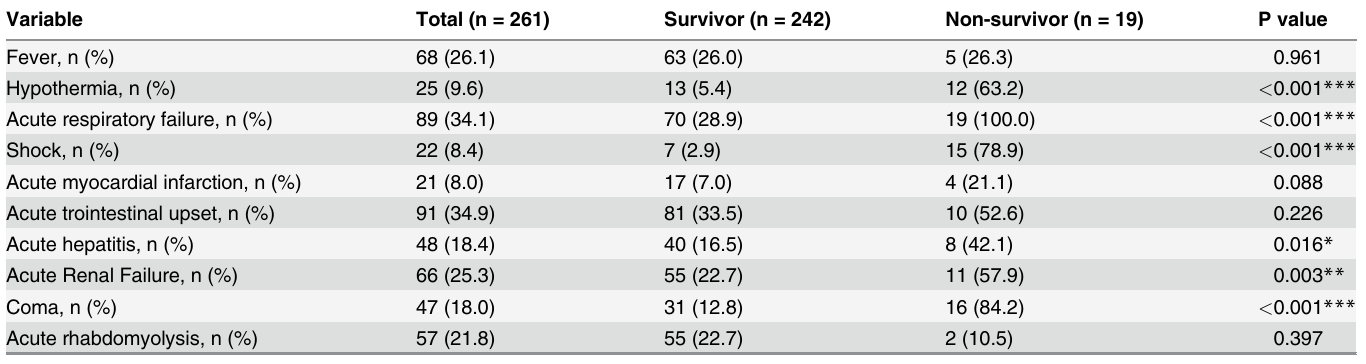
Table 2. Clinical manifestations of patients with CO poisoning, strati fi ed according to status at discharge as alive (survivors) or dead (non- survivors).